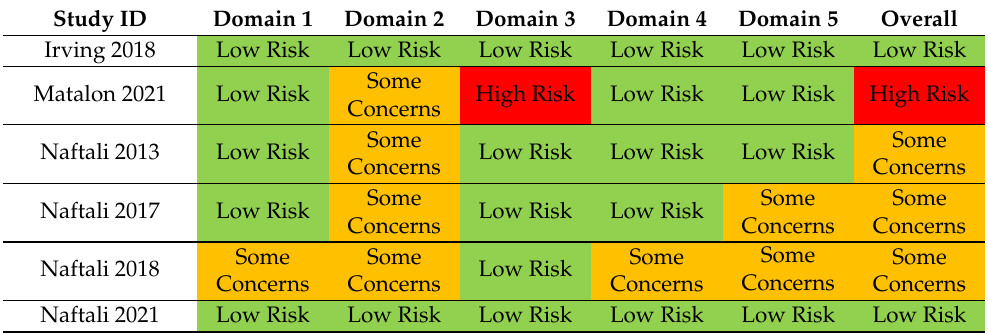
Table 4. RoB quality assessment of included studies. Green: low risk of bias; Yellow: some concerns in bias assessment; Red: High risk of